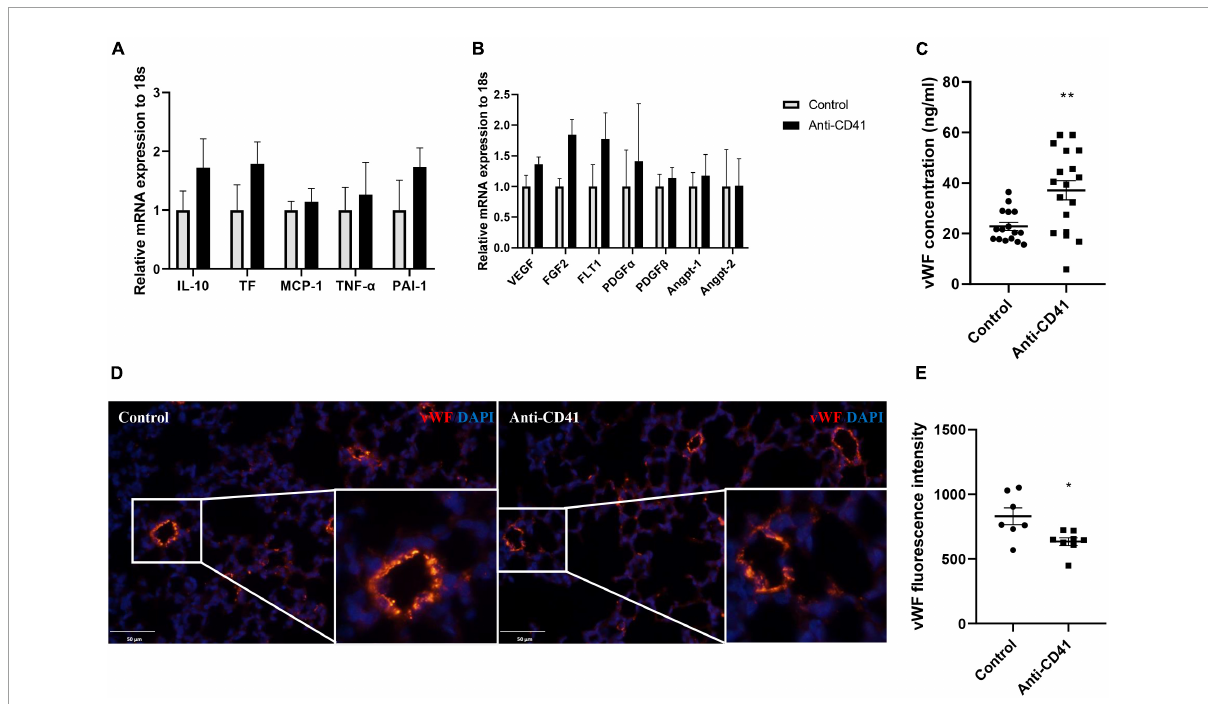
FIGURE3 Platelet depletion disrupted endothelial function. mRNA in whole lung tissues was obtained from mice injected with anti-CD41 and control and analyzed by RT-PCR. Expressions of interlukin-10 (IL-10), tissue factor (TF), monocyte chemoattractant protein-1 (MCP-1), tumor necrosis factor – α (TNF- α ), plasminogen activator inhibitor –1 (PAI-1) were relatively quantified in (A) , expressions of vascular endothelial growth factor (VEGF), fibroblast growth factor 2 (FGF2), VEGF receptor 1 (FLT-1), platelet-derived growth factor α (PDGF α ), PDGF β , angiopoietin 1 (Angpt-1), and Angpt-2 were relatively quantified in (B) , using 18S rRNA as a reference control ( n = 6–8). Quantification of plasma concentration of vWF (C) in controls ( n = 16) and mice injected with anti-CD41 ( n = 18). Representative images of vWF staining in lung tissue (D) and quantification of vWF fluorescence intensity (E) in controls ( n = 7) and mice injected with anti-CD41 ( n = 8). Data are expressed as mean ± SEM, * p < 0.05, ** p <